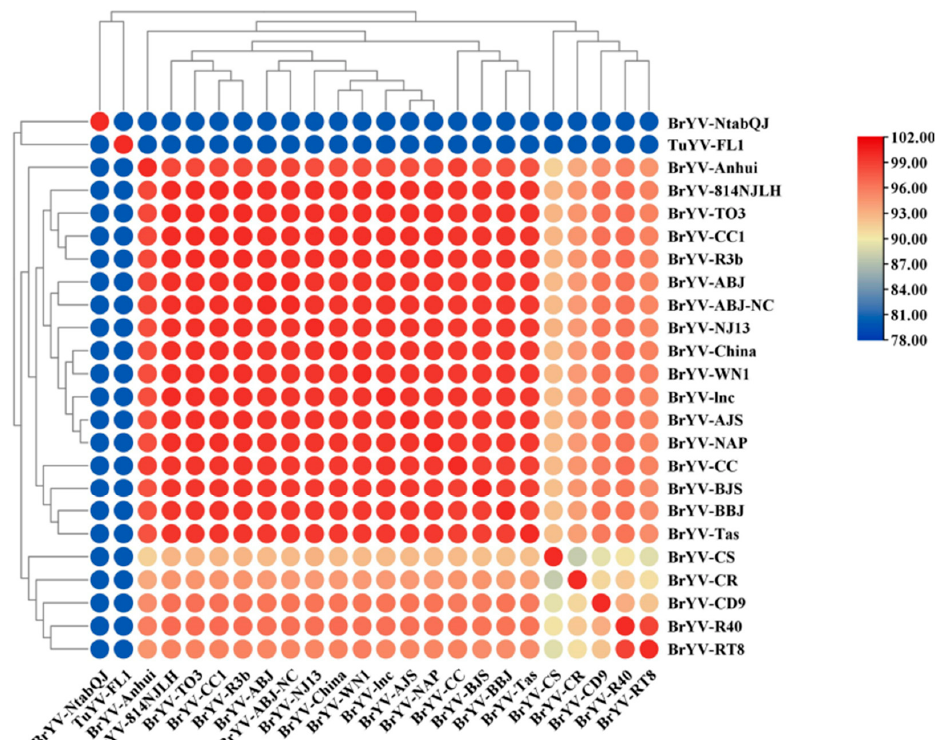
Figure 5. Pairwise amino acid analysis based on the phylogenetic tree of BrYV P5. The matrix shows the identity of amino acids (aa) between the different virus isolates. The order of the isolates was determined by the contralateral phylogenetic tree. The color of the dots indicates the pairwise amino acid identity.